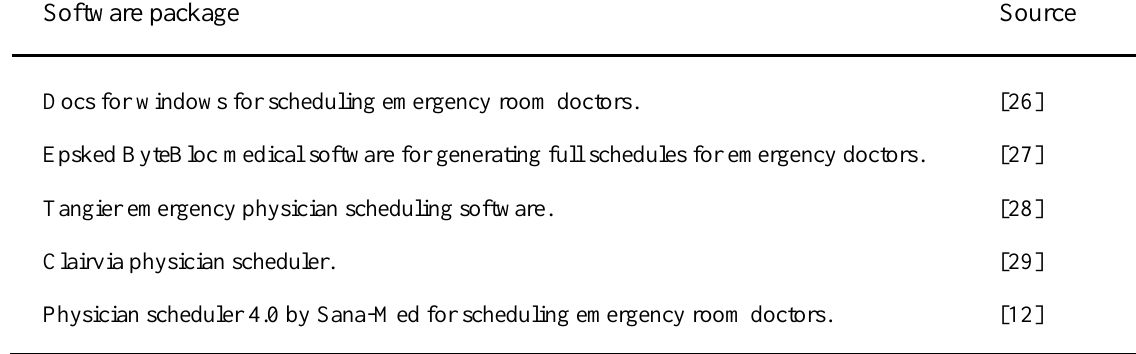
Table 1. Scheduling